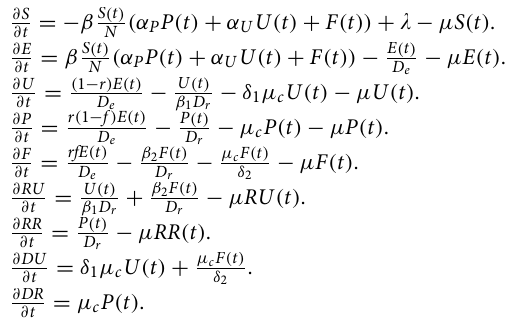
The appearance and spread of COVID-19 have taken the entire world by a storm, but a large number of exam- ples from all across the world clearly depict that we can change the narrative and course of this virus through extensive testing, contact tracing, use of masks, hand hygiene and social distancing. For example, Delhi has seen tremendous success in turning the corner of the virus curve, with the time-varying reproduction number stay- ing below unity for the larger part of the period between September 2020 and February 2021 (Supplementary Figs. 4–5). This trend of improved containment, however, seems to have reversed in the recent times, with the estimated time-varying reproduction number undergoing an alarming increase above unity during March–April 2021 (Supplementary Fig. 5). Several factors including public complacency, waning immunity that was acquired from past infections and the emergence of new variances may have contributed to this surge 58 . The appearance of these escalated numbers also calls for closer inspections of the serosurvey-based estimates, since a >